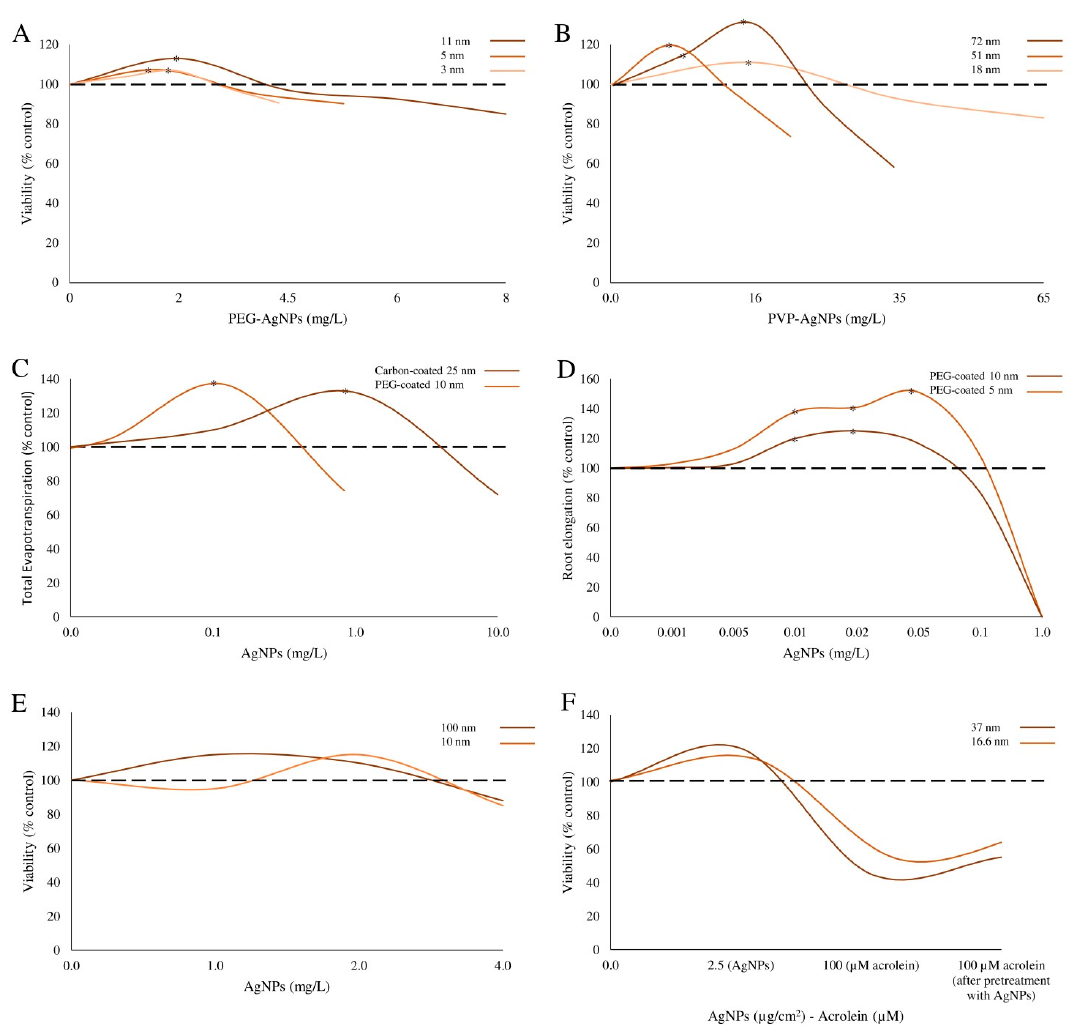
Figure 3. Examples of NP size-dependent biphasic response. ( A , B ) In E. coli cells, the exposure to Ag-NPs induced a hormetic response regardless of NP size and functionalization (modified by Xiu et al. [16]). ( C ) Biphasic response of cumulative evapotranspiration was observed in poplars ( Populus deltoides × nigra ) exposed to carbon- and PEG-coated Ag-NPs of 25 and 10 nm, respectively (modified by Wang et al. [26]). ( D ) PEG-coated Ag-NPs of 5 and 10 nm affected the root elongation of Arabidopsis thaliana showing a hormetic effect (modified by Wang et al. [26]). ( E ) Ag-NPs of different size (10 and 100 nm) showed a hormetic cell proliferation response in HepG2 cells (modified by Jiao et al. [13]). ( F ) Pretreatment of human A549 lung epithelial cells with low doses of Ag-NPs reduced the cytotoxic effect caused by acrolein and/or by exposure to higher doses of the same NPs (modified by Sthijns et al. [12]). * Indicates statistical significance ( p < 0.05).